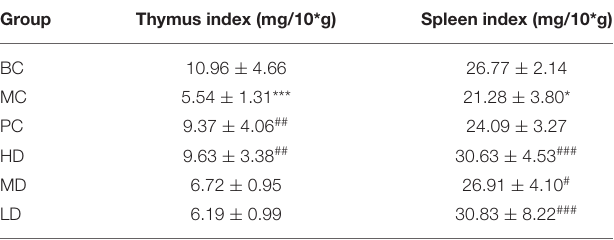
TABLE 1 | Effect of F. velutipes polysaccharide on the index of immune organs. Group